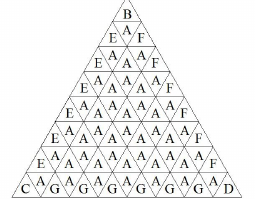
Figure 4. Categories of grids in one octant [Chen et al.